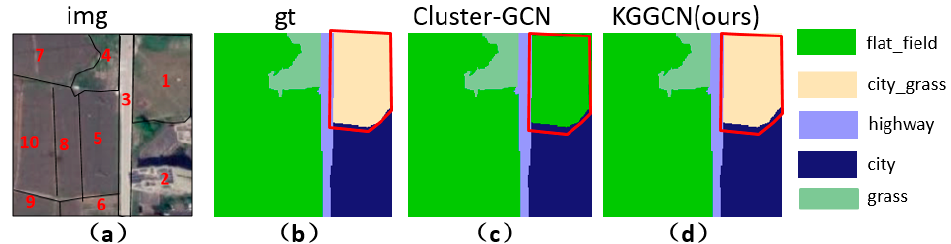
Figure 23. Demonstration of one sample. ( a ) is raw remote sensing image, and superpixel blocks are marked in the image; ( b ) is the ground truth of this image; ( c ) is the prediction of Cluster-GCN; ( d ) is the prediction of KGGCN.